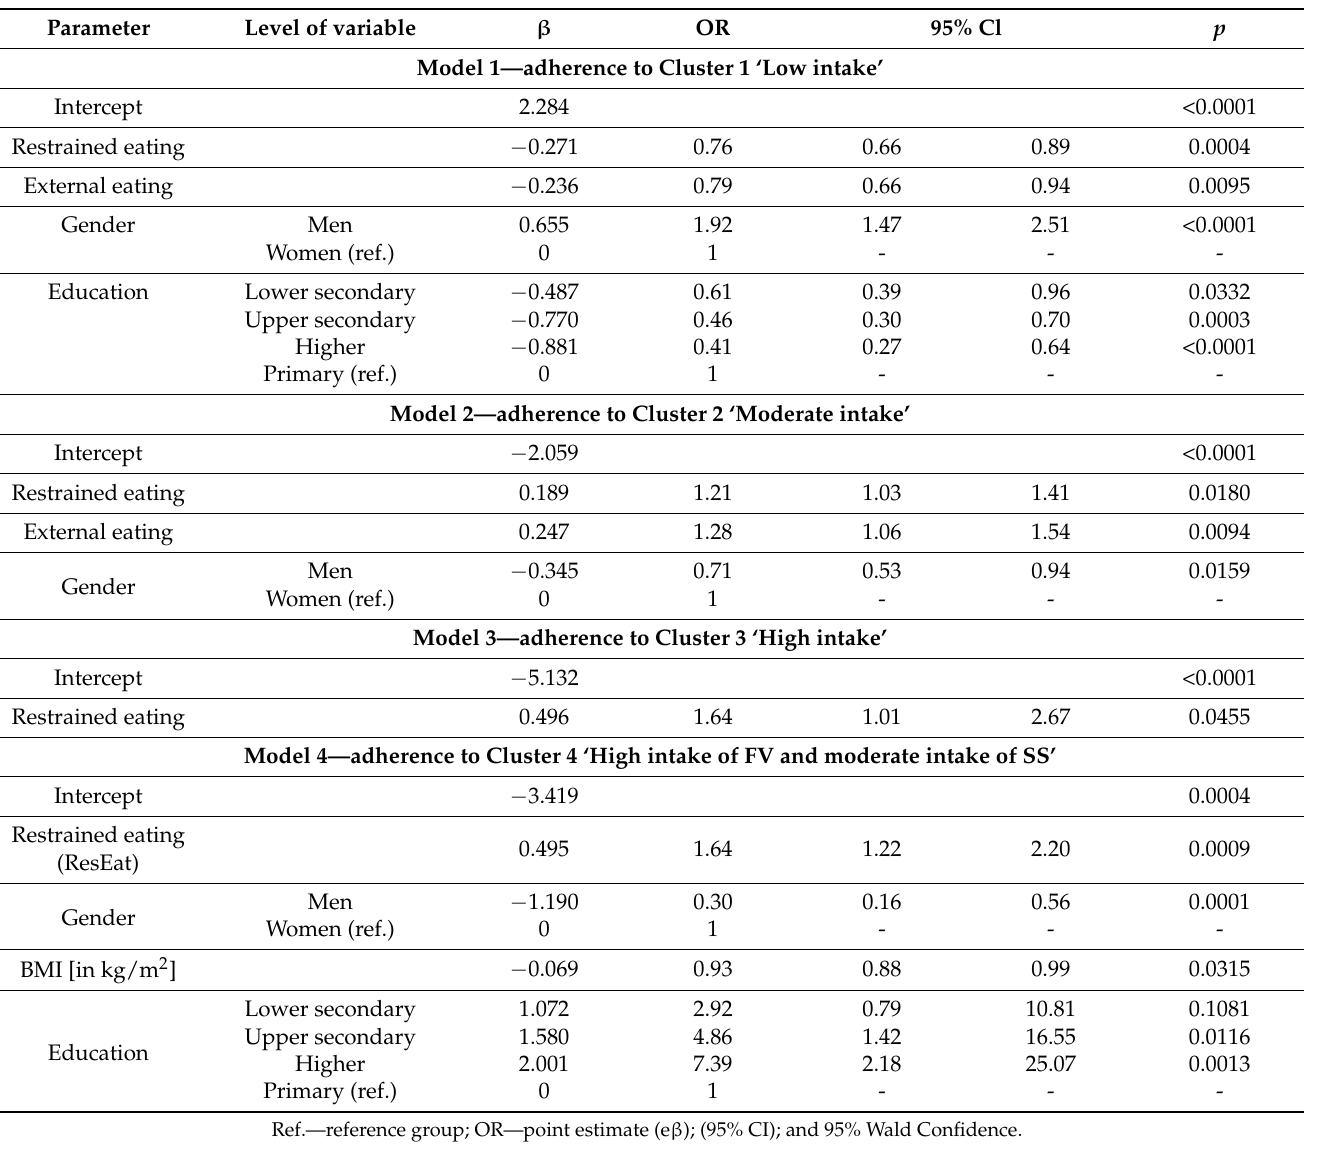
Table 10. Cluster’s odds ratios (OR; 95% CI) in the study